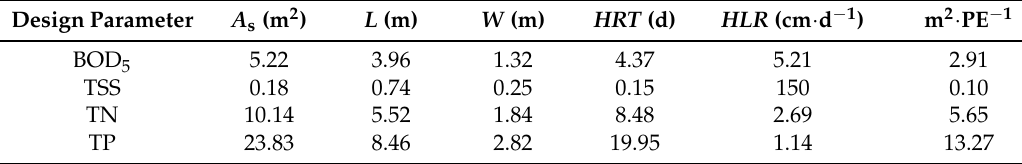
Table 5. HF-CW theoretical areas for BOD 5 , TSS, TN and TP according to Reed’s method. Design